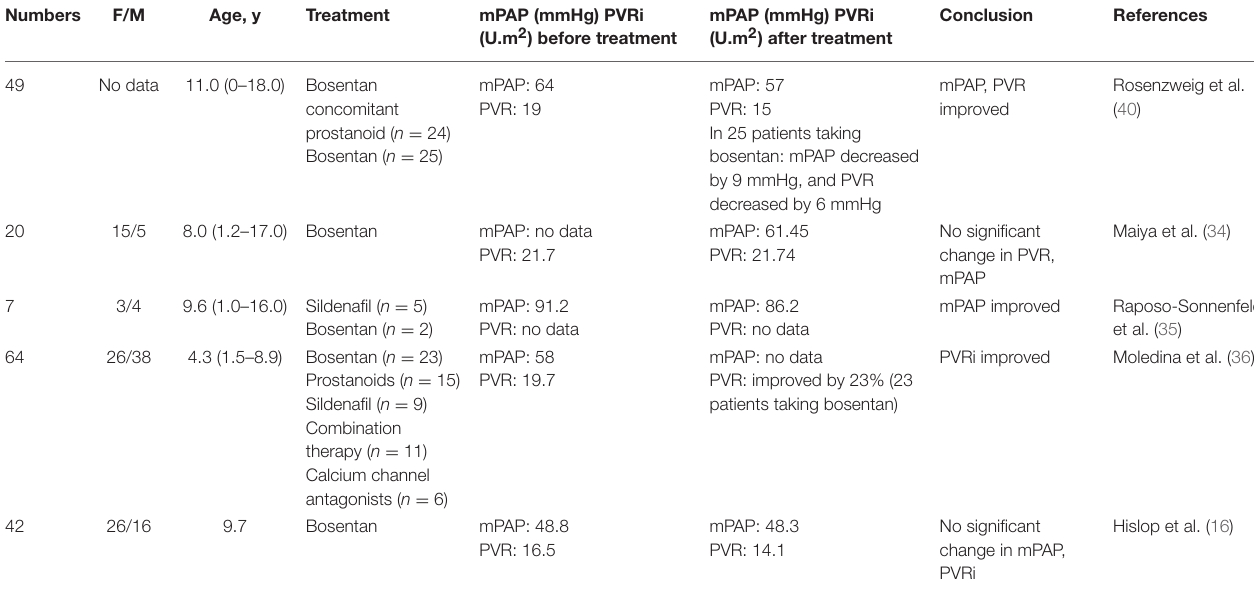
F, Female; M, Male.